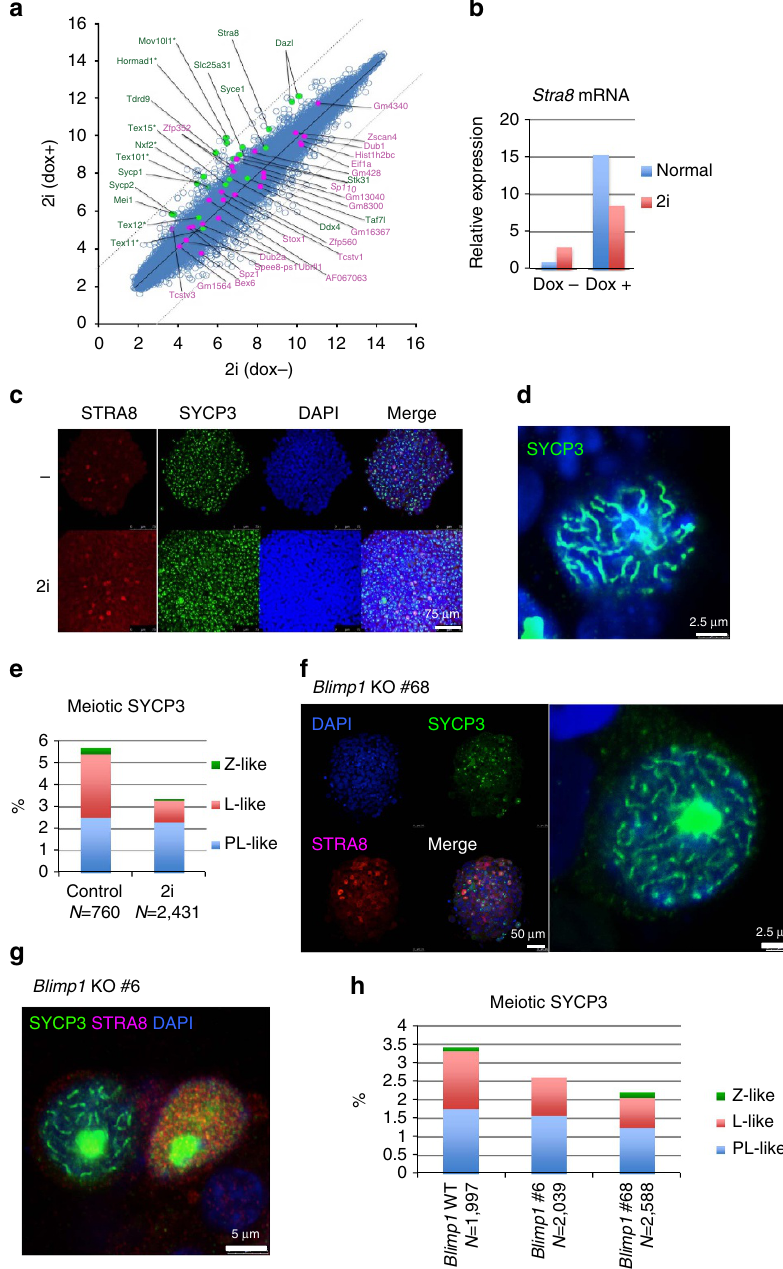
Figure 5 | Occurrence of meiosis-like changes in Max expression-ablated ESCs without passing through the PGC state. ( a ) Scatter plots of DNA microarray data from untreated and Dox-treated Max -null ESCs cultured under the 2i þ LIF condition. Genes highlighted in Fig. 1a are indicated by the same colours (green: germ cell-specific genes; pink: two-cell embryo-specific genes; green with an asterisk: genes belonging to both categories). ( b ) Measurement of Stra8 mRNA levels by quantitative PCR in Dox-untreated and -treated Max -null ESCs cultured under conventional mouse ESC or 2i þ LIF culture conditions. ( c ) Immunocytochemical analyses of STRA8 and SYCP3 in Dox-treated Max -null ESCs cultured under conventional mouse ESC or 2i þ LIF culture conditions. ( d ) Representative image of the zygotene-like SYCP3-staining pattern observed in Dox-treated Max -null ESCs cultured under the 2i þ LIF condition. ( e ) Frequency of meiosis-like SYCP3-staining patterns in Dox-treated Max -null ESCs cultured under conventional mouse ESC or 2i þ LIF culture conditions. ( f ) Immunocytochemical analyses of STRA8 and SYCP3 in the Dox-treated Blimp1 KO #68 Max -null ESC clone. Right panel shows a representative zygotene-like SYCP3-staining pattern. In this mutant clone, a single adenine nucleotide was inserted into both loci of exon 3 in the Blimp1 gene, causing an out-of-frame mutation (for details, see Supplementary Fig. 8). ( g ) Leptotene-like immunostaining pattern of SYCP3 with high STRA8 expression (right) and the zygotene-like SYCP3-staining pattern (left) with low STRA8 expression in the Dox-treated Blimp1 KO #6 Max -null ESC clone in which a large deletion had occurred in the region encompassing exon 3 and intron 3 in both loci of the gene (for details, see Supplementary Fig. 8). ( h ) Frequency of meiosis-like SYCP3-staining patterns in Dox-treated Max -null ESCs of Blimp1 KO #68 and #6 clones. KO,